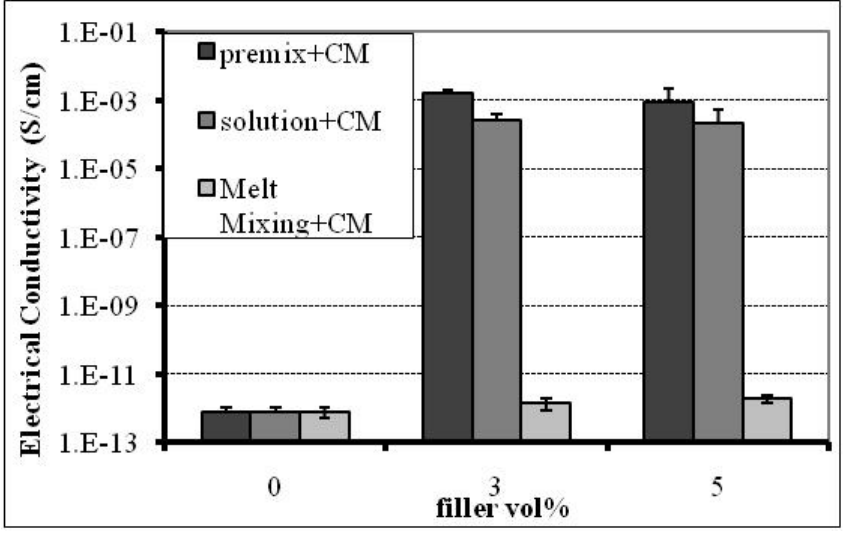
Figure 8. Effect of compounding on the percolation threshold and conductivity of xGnP-1- PP nanocomposites made by compression